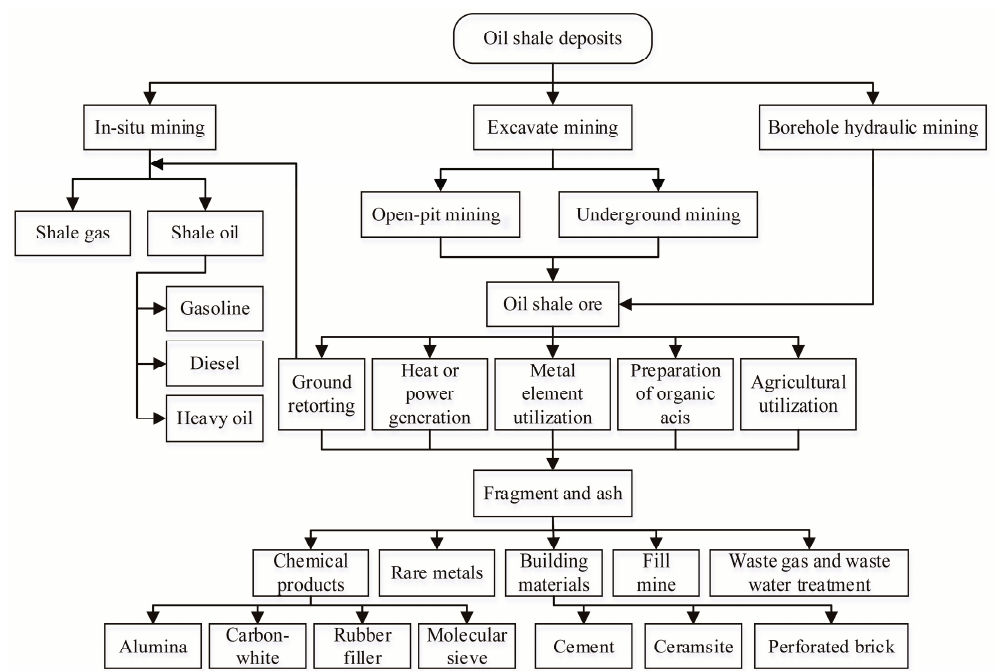
Figure 1. Oil shale mining and comprehensive utilization methods.